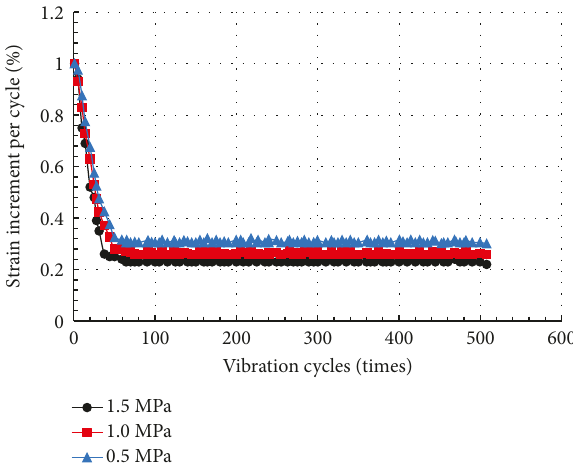
Figure 13: Relation between strain increase per vibration cycle and vibration